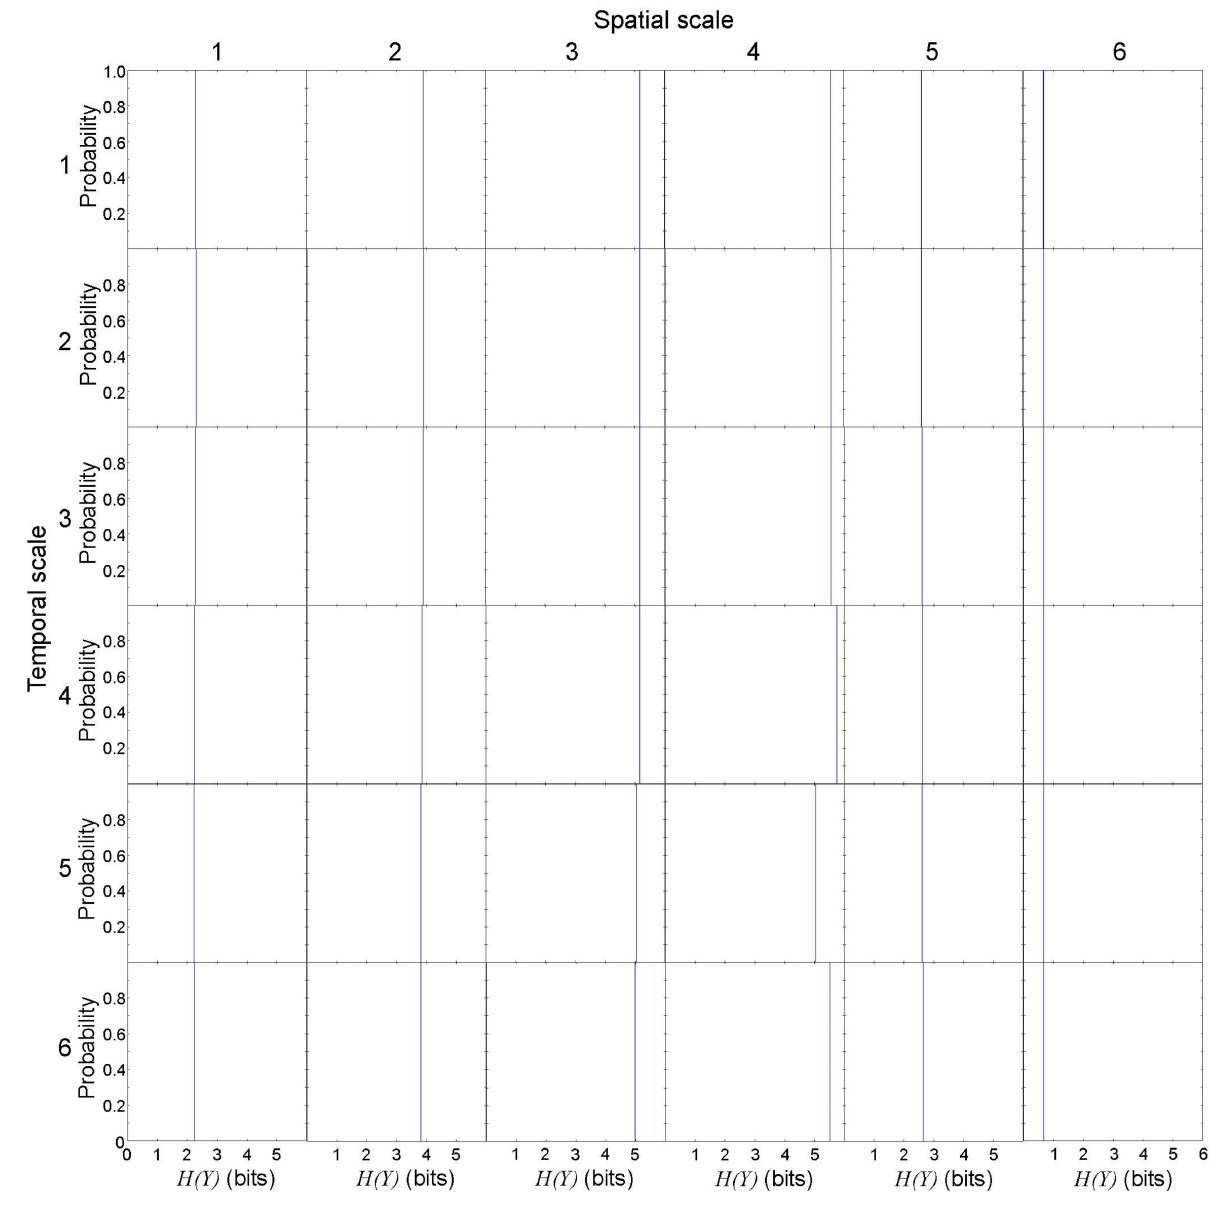
FIGURE 4 | Entropy of specific state of possible effect Y in a representative spiral wave data set. H ( Y ) is uniquely determined because it represents a specific state of the system regardless of the spatiotemporal scale. Each subplot represents the probability distribution of H ( Y ). The columns represent the spatial scales (1 through 6) and the rows represent the temporal scales (1 through